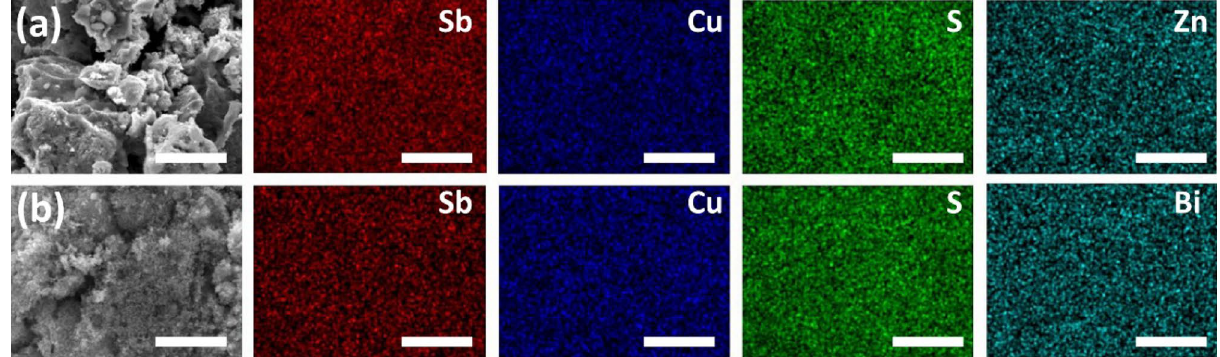
Figure 8. EDX elemental mapping (20 kV) of Cu Kα, Sb Lα, S Kα and Zn Kα/Bi Mα for ( a ) Cu 12−x Zn x Sb 4 S 13 (x = 1.5) and ( b ) Cu 12 Sb 4−x Bi x S 13 (x = 0.5). Scale bars = 5